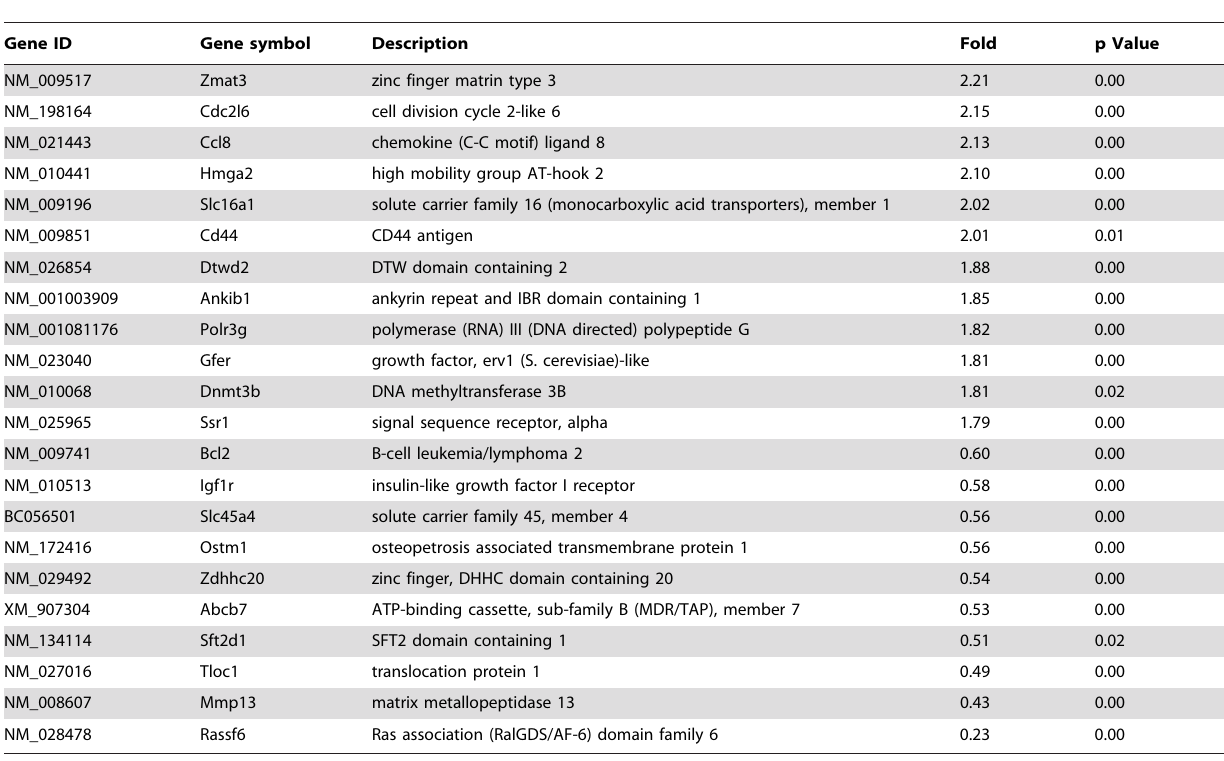
Table 4. Effect of decreased RASSF6 expression on gene expression in 3T3-L1 adipocytes.